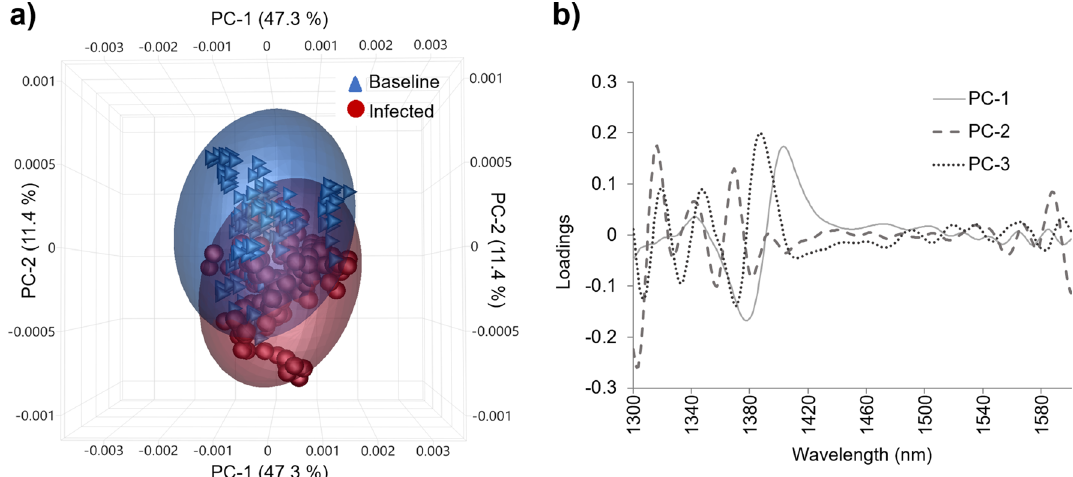
Figure 3. Principal component analysis (PCA) of the transformed blood plasma NIR spectra (1300–1600 nm) collected before and after the M. haemolytica challenge using the balanced spectral database DB0 (n = 300). ( a ) PCA scores plot for samples from the baseline and infected periods containing the scores from the first three PCs explaining 66.7% of the total variance. ( b ) PCA loadings showing the dominant peaks influencing the trends in the scores plot: PC-1 = 47.3%, PC-2 = 11.4%, PC-3 =